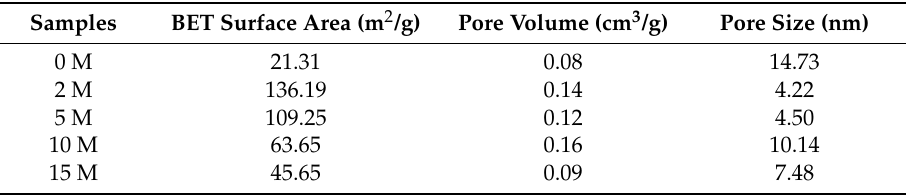
Figure 5. ( a ) N 2 adsorption–desorption isotherm of as-prepared samples; ( b ) pore diameter of the as- prepared samples. Table 2. Physicochemical properties of samples. Table 2. Physicochemical properties of samples.